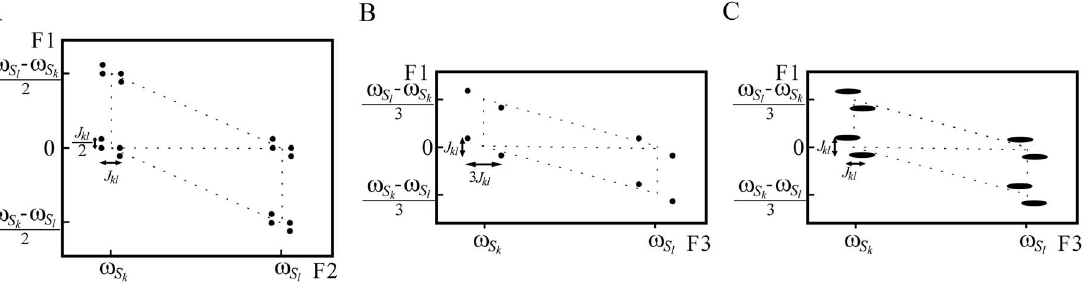
Figure 2. Schematic SECSY spectra for an AX spin system: (A) conventional SECSY in homogeneous fields; (B) and (C) DDF-SECSY and DDF-SECSY with the ultrafast acquisition scheme recovered from inhomogeneous fields.